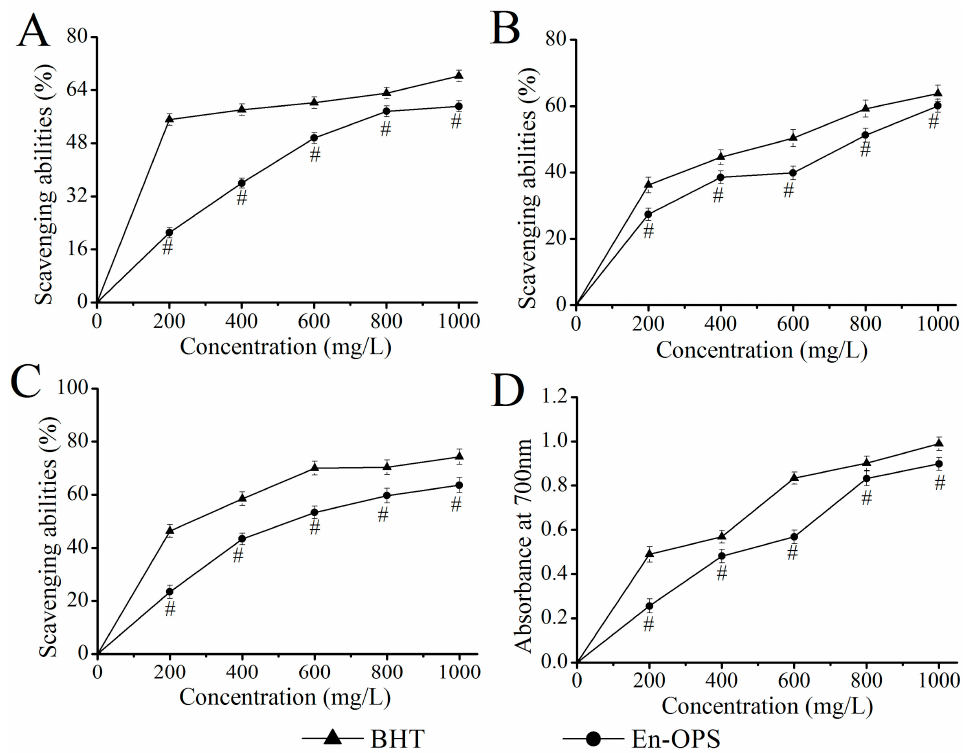
Figure 1. Antioxidant activities of En-OPS in vitro. ( A ) hydroxyl radical-scavenging abilities; ( B ) superoxide radical-scavenging abilities; ( C ) 1,1-diphenyl-2-picrylhydrazyl radical-scavenging abilities; and ( D ) reducing power. “#” indicated that the values differ significantly at p < 0.05 (En-OPS compared with BHT at different concentration). The statistical significance of the differences between the groups were analyzed using Tukey’s tests in the software package (SAS 9.3). A value of p < 0.05 was regarded as statistically significant.